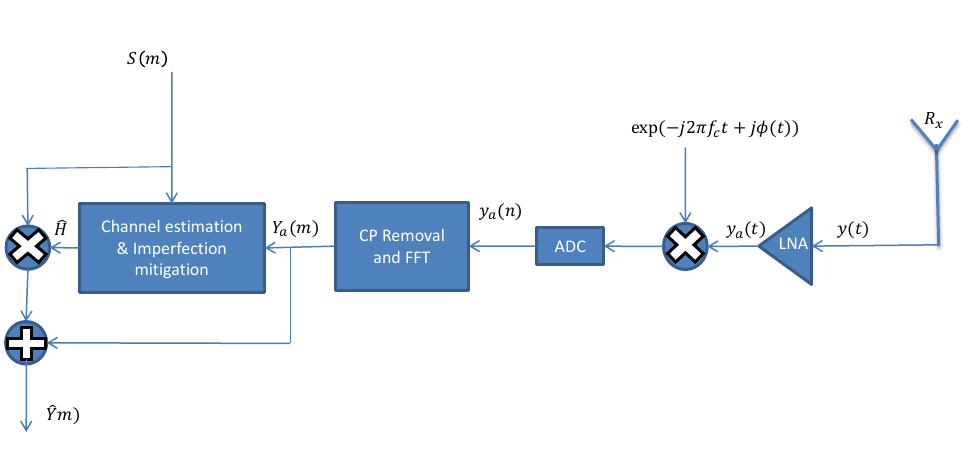
Figure 1. SIC circuit for OFDM receiver